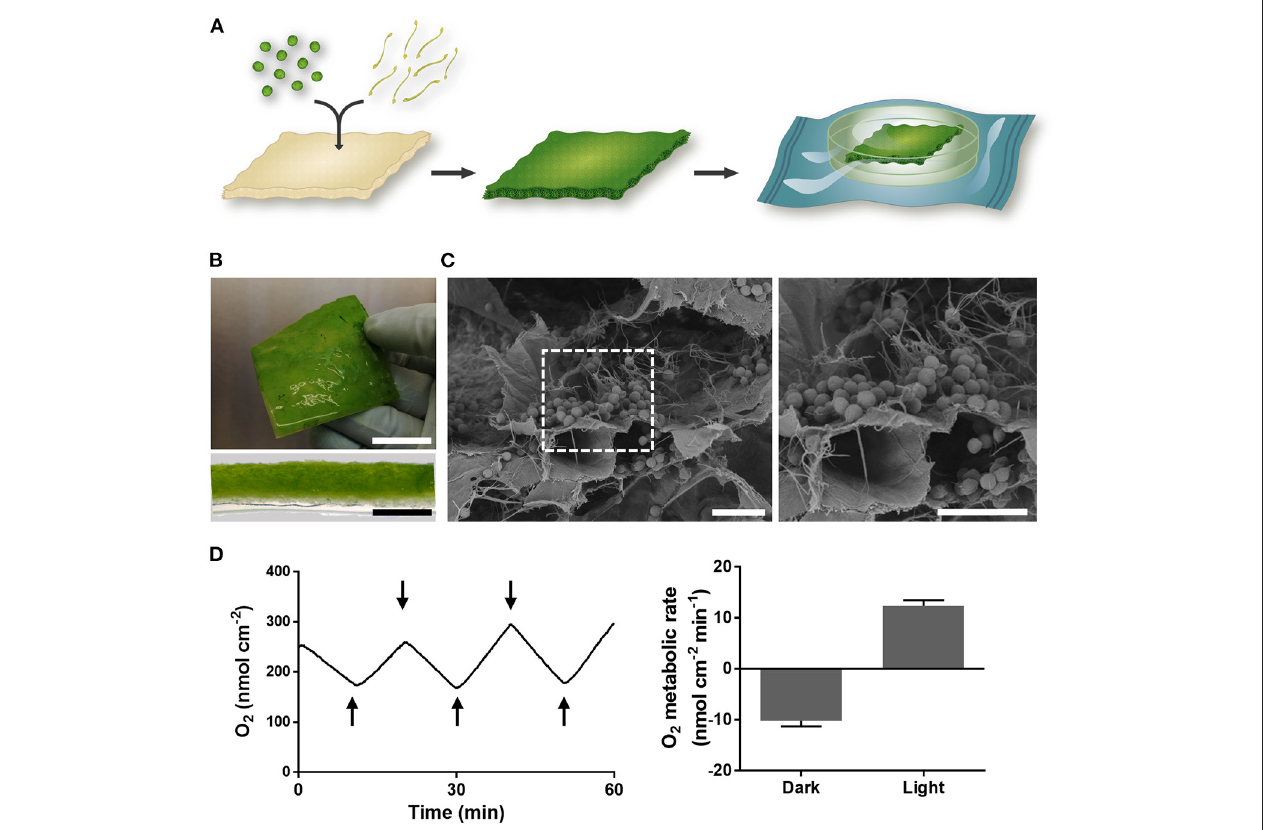
FIGURE 1 | Photosynthetic scaffold fabrication and characterization. (A) Microalgae and fibrin were seeded in a commercially available collagen scaffold and allowed to grow during 4 days. Once sterility of the material was confirmed, scaffolds were packaged and delivered to the operating room. (B) Macroscopic image (top) and cross section (bottom) of photosynthetic scaffold. (C) SEM imaging showing microalgae embedded in the fibrin matrix inside the scaffold. (D) Representative evolution of oxygen concentration upon dark/light cycles of 10min, represented by upper and lower arrows respectively (left), and scaffold metabolic rates (right). Scale bars represent 2cm ( B , top), 2mm ( B , bottom) and 20 µ m (C) . Data in (D) is representative of at least five independent experiments and is expressed as mean value ± SEM